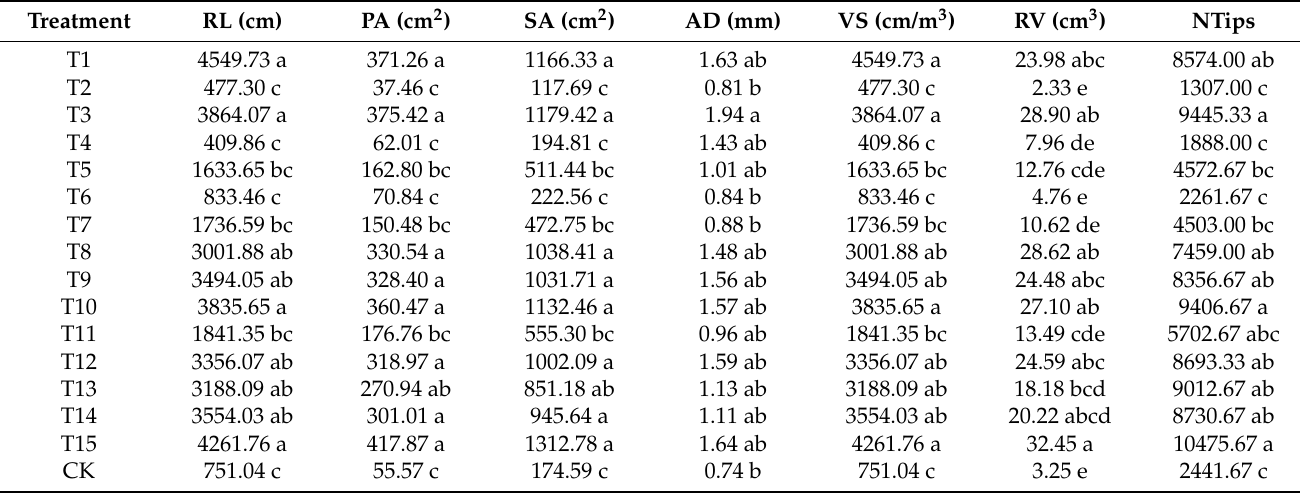
Figure 3. Images of roots of H. chrysanthus that were developed in different mixed substrates. T1, T2, T3, and CK refer to the numbers of various mixed substrates. Table 4. Statistical analysis of root morphological traits of H. chrysanthus with different mixed substrates. RL, root length; PA, projected area; SA, surface area; AD, average diameter; VS, length per cubic centimeter; RV, root volume; NTips, root tip number.